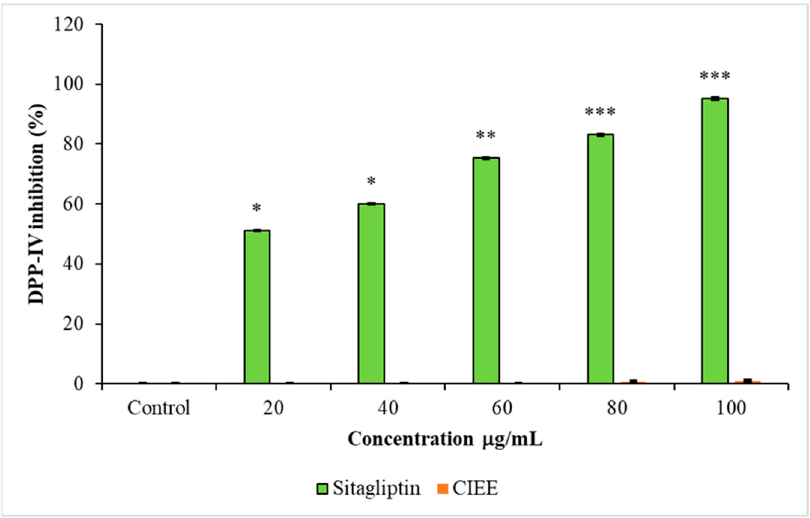
Figure 7. The effect of ethanolic extract of C. incana on DPP-IV activity. CIEE: Calamintha incana ethanolic extract, sitagliptin: positive control. Data stated as the mean ± SD (N = 3). * p < 0.05, ** p < 0.01, *** p < 0.001 vs. untreated enzyme (control) (ANOVA, Tukey’s post hoc test).